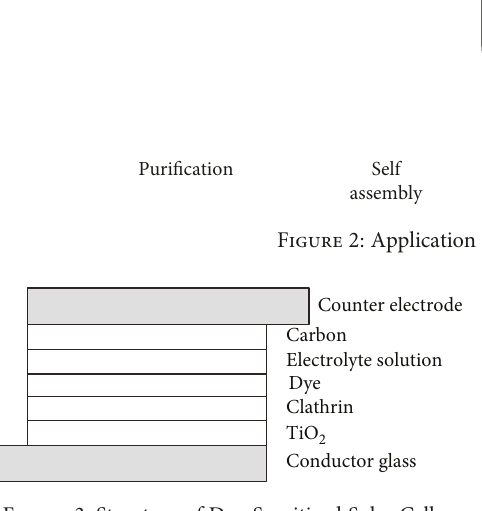
Figure 3: Structure of Dye-Sensitized Solar